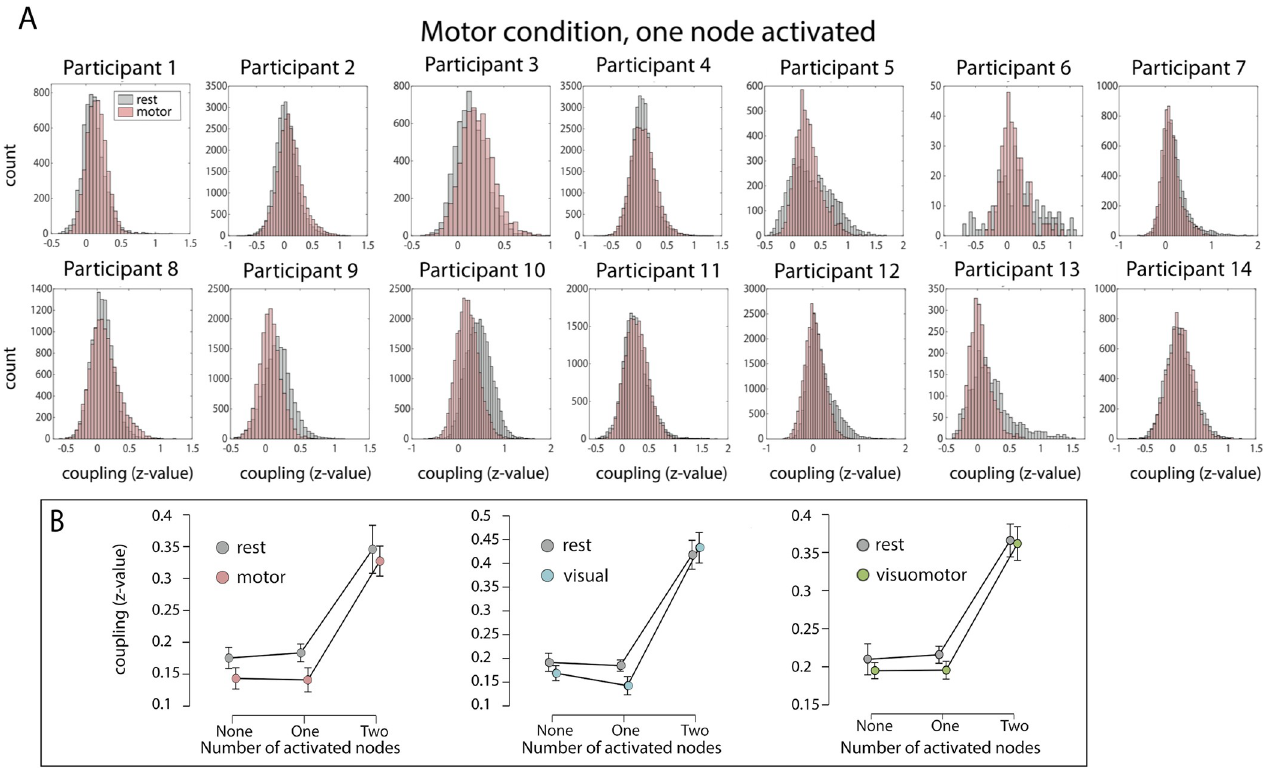
Fig 3. Relationship between task-evoked activation and differences between task-based and resting state FC. (A) Fisher z-transformed correlation coefficients between pairs of nodes, where only one of the nodes is activated during the motor steady-state condition, are displayed separately for each participant in the form of a histogram (y-axis depicting the number of node pairs in each bin; please note that the range of the y axis differs across individuals due to differences in the total amount of nodes activated during the task). If intrinsic connectivity changes with task activation, then FC should consistently decrease in the task-state, when only one of the nodes is activated, as compared to the resting-state. Although this is true for some participants (e.g. Participants 9 and 10), others show an opposite trend (connectivity increased in the motor condition, see e.g. Participants 1–3). (B) Relationship between number of activated nodes and mean FC for the three task comparisons (motor–pink, visual–blue, visuomotor—green). Note that while a significant main effect of the factor "number of activated nodes" (x-axis) can be observed, no significant interaction between activated nodes and task was found. Error bars indicate standard error of the